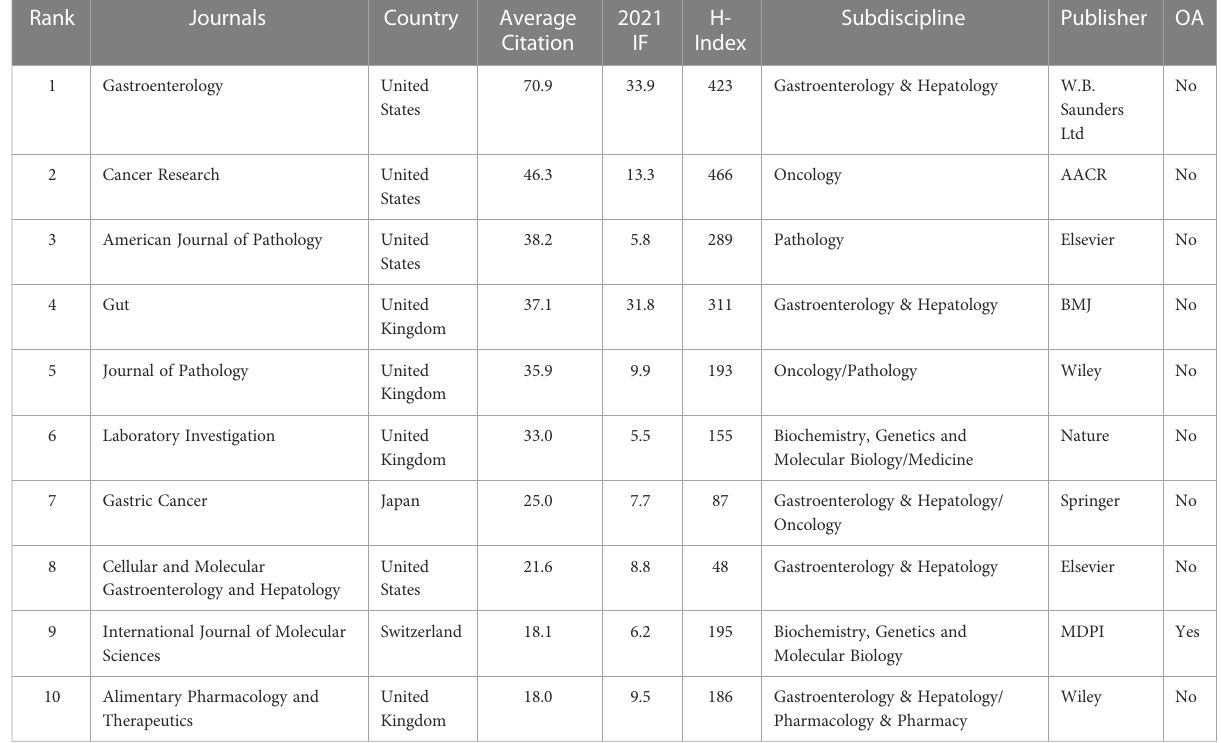
TABLE 4 The top 10 JCR Q1 Journals involved in SPEM-GC